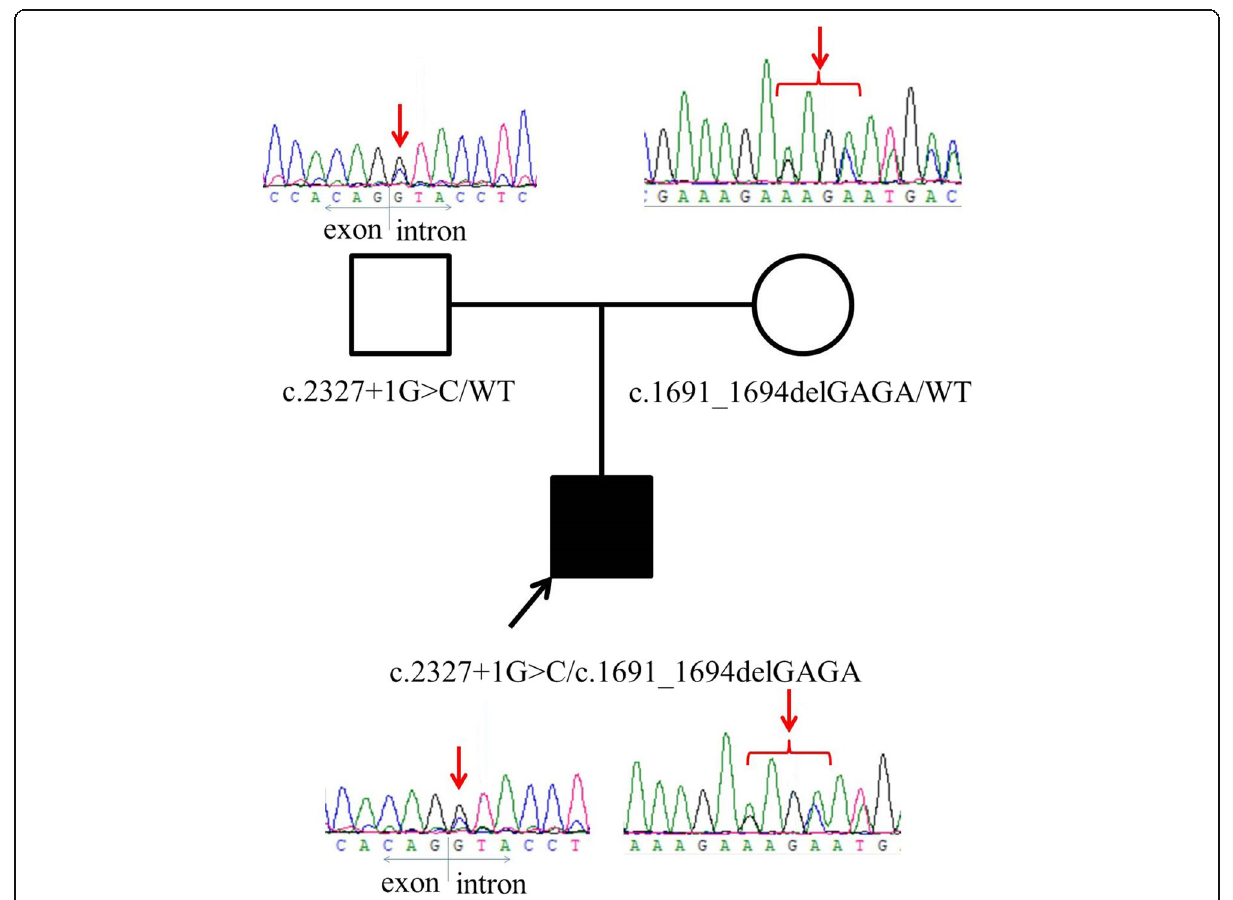
Fig. 1 Pedigrees of PLIN2 mutation family and Sanger